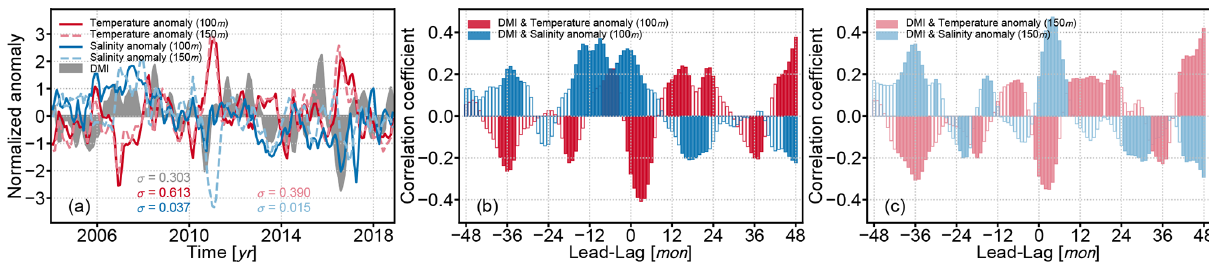
Figure 8. Normalized 3-month running mean of DMI, temperature anomaly, and salinity anomaly at the subsurface of the BoB from Argo- based RG_Clim are shown in (a) . The standard deviation σ is labeled with the corresponding color. Their respective lead–lag relations described by the Pearson correlation coefficient between the DMI and subsurface anomalies are shown in (b) for 100m and (c) of 150m. Only significant correlation coefficients with p value < 0 . 05 are shaded.